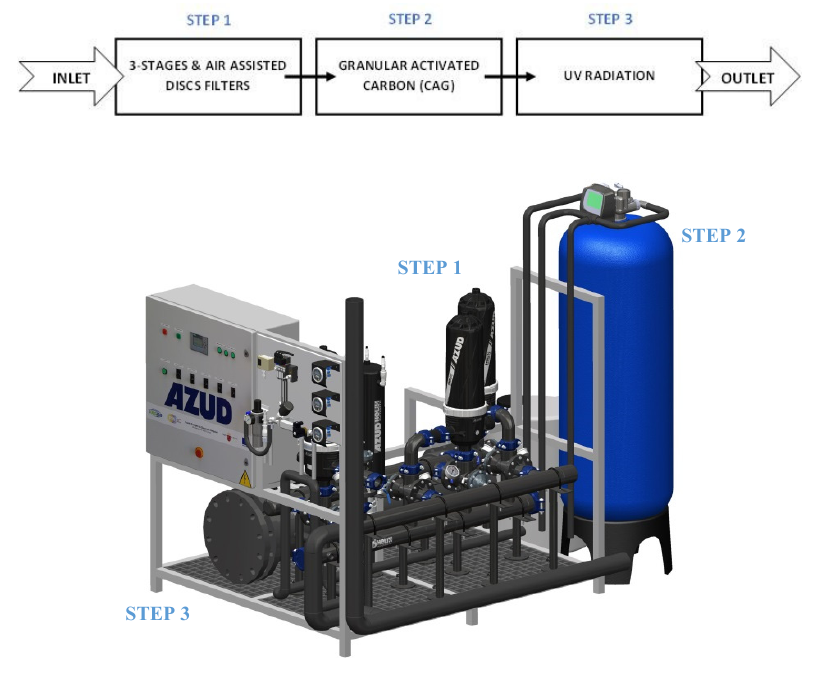
Figure 1. Prototype design.